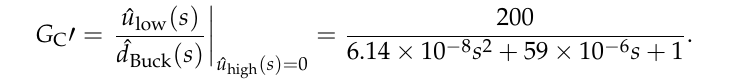
Figure 10. According to Figure 10, the crossover frequency of the proposed converter is higher than that of the traditional two-level converter due to smaller